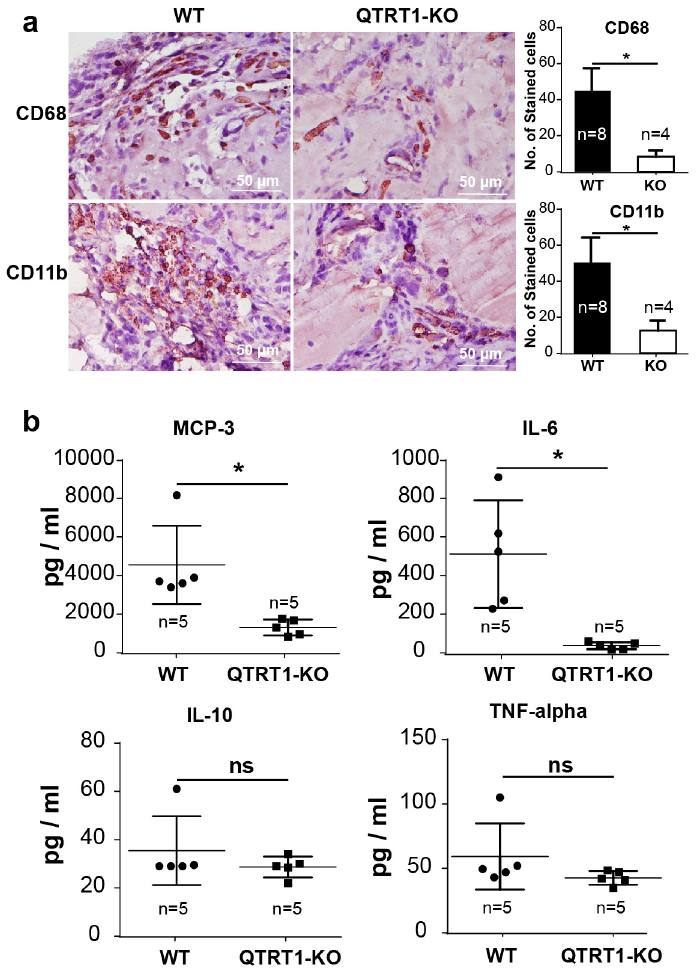
Figure 5. Inflammation regulators in tumors and plasma of nude mice. ( a ) Immunostaining of inflammation-related cells in tumors from nude mice with anti-CD68 and anti-CD11b. The number of stained cells were calculated in each visual filed. Scale bar is 50 µ m. Mean ± SD, n = 8 or n = 4; * p -value < 0.05, two-tailed Welch’s t -test. ( b ) Mouse cytokine levels in the plasma of nude mice injected with WT and QTRT1-KO MCF7 breast cancer cells were determined by multiplex bead-based assays for 26 cytokines and chemokines. Mean ± SD, n = 5; * p -value < 0.05, ns means no significance.